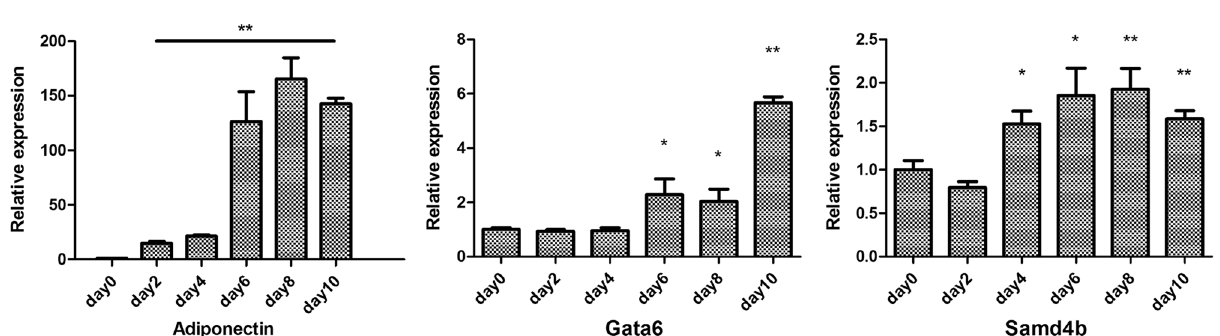
Figure 2. Expression of gata6 and samd4b during the differentiation of stromal vascular cells (SVC) into mature adipocytes. The results are presented as mean values ± standard error of the mean (SEM). p -values < 0.05 were considered statistically significant and indicated with a * for p < 0.05 and ** for p <